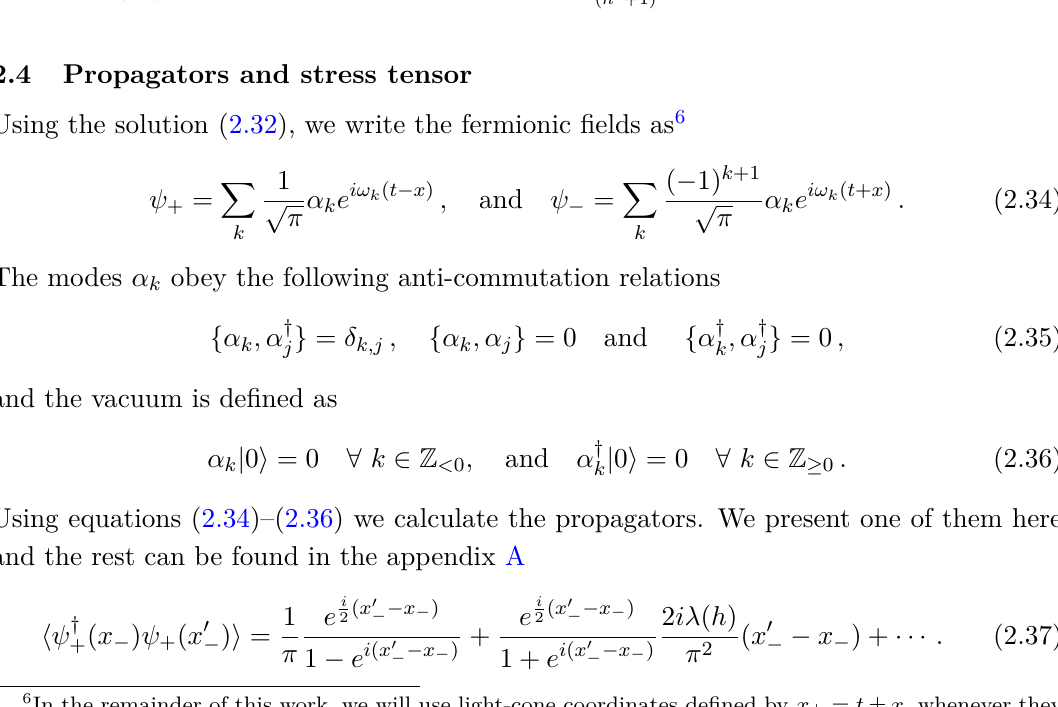
| = 1 , traveling on the strip hits + , and the right ( h 2 +1) 2 ( h 2 +1) 2